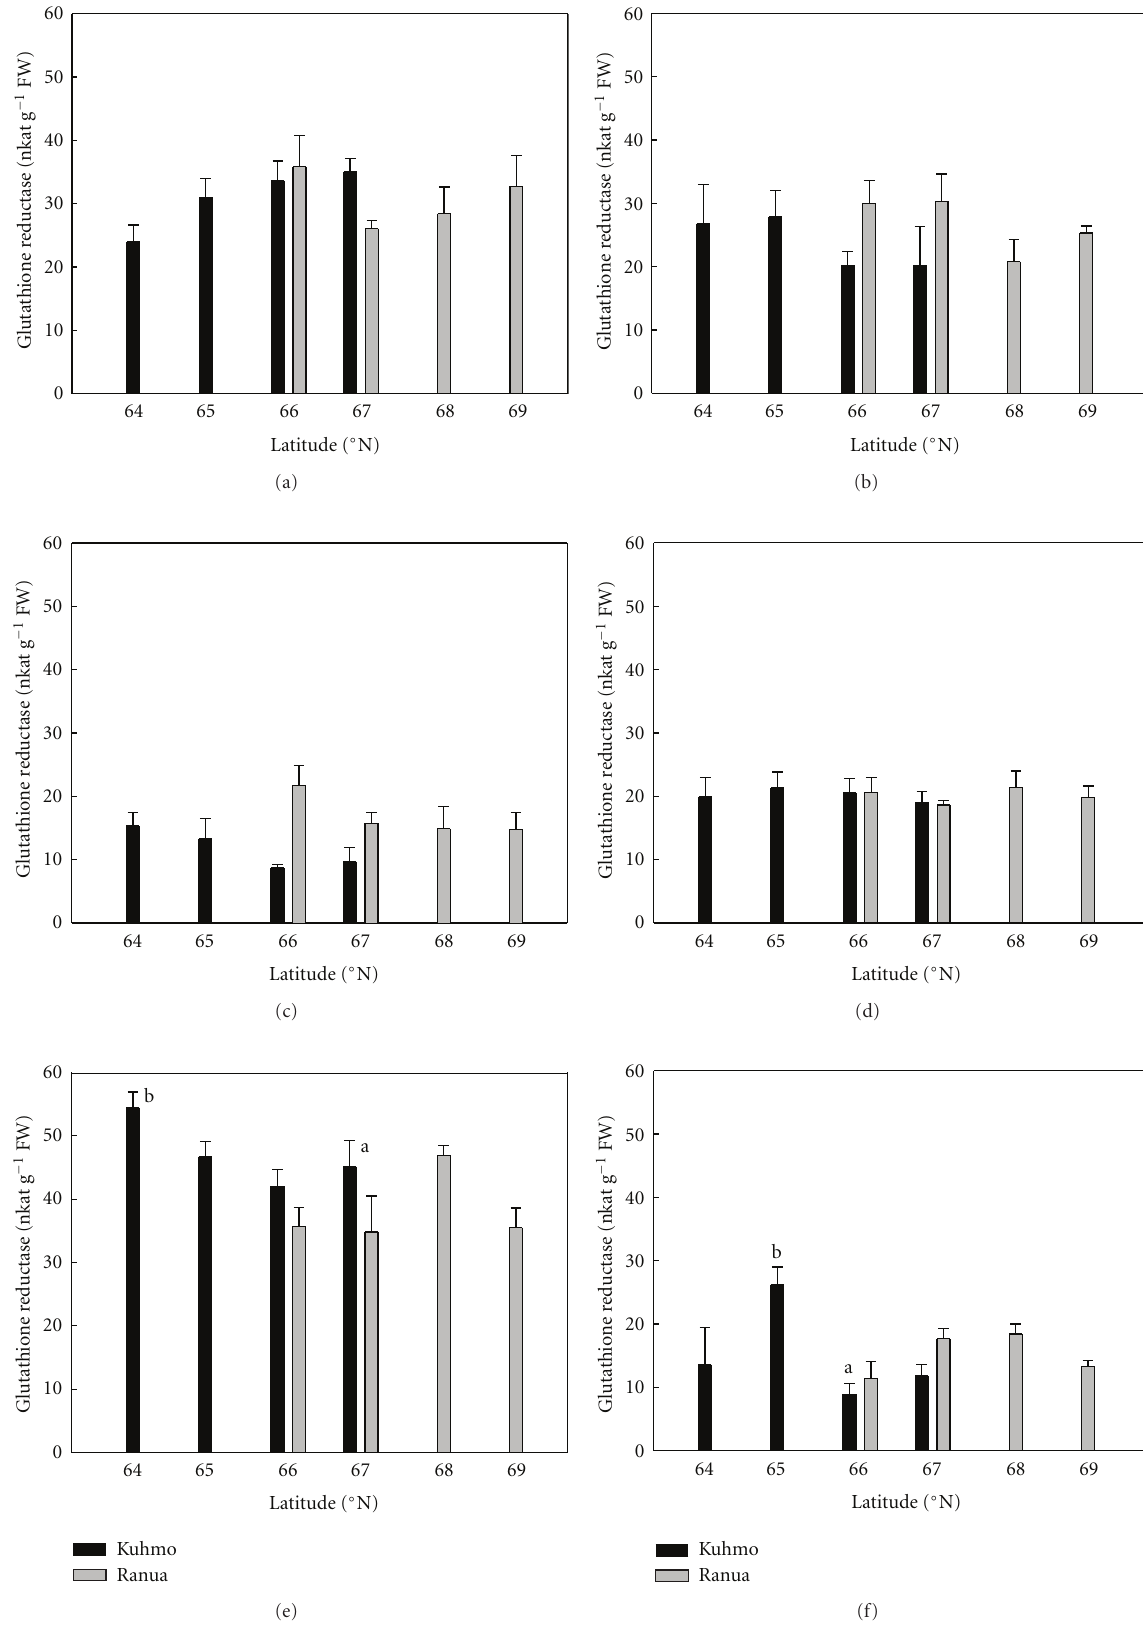
Figure 8: Glutathione reductase activity (mean ± SE, n = 5 − − 7), text otherwise as in Figure